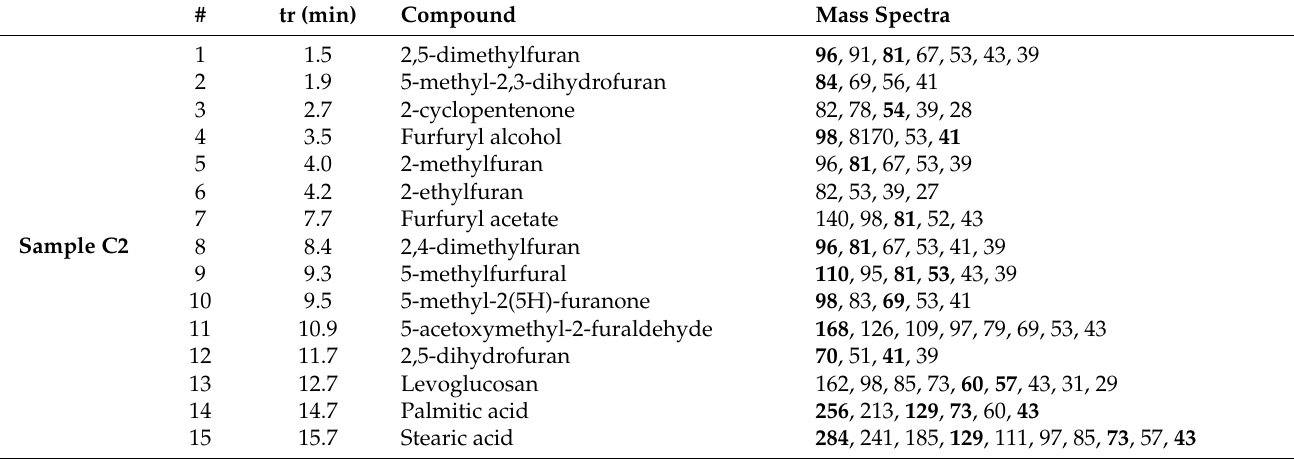
Table 2. Main pyrolysis products detected in the pyrograms of samples C2, C5, C7, C8, and C11 reported in Figure 3a–e. The most intense peaks are reported in